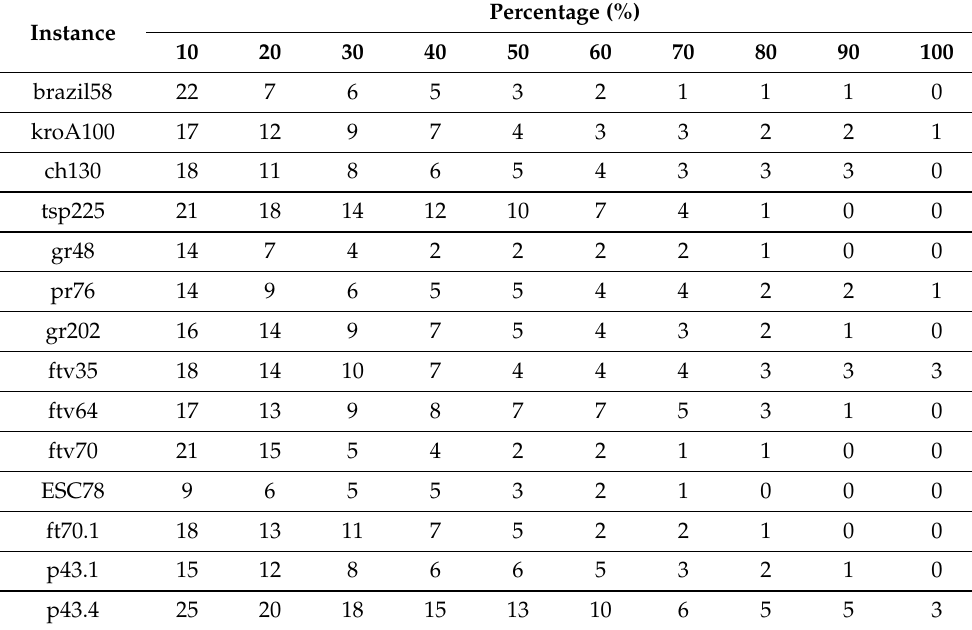
Table 2. Analysis of the number of times from the 30 runs that AS Rank was able to find a better solution after different percentages of solutions (ants) have reached null standard